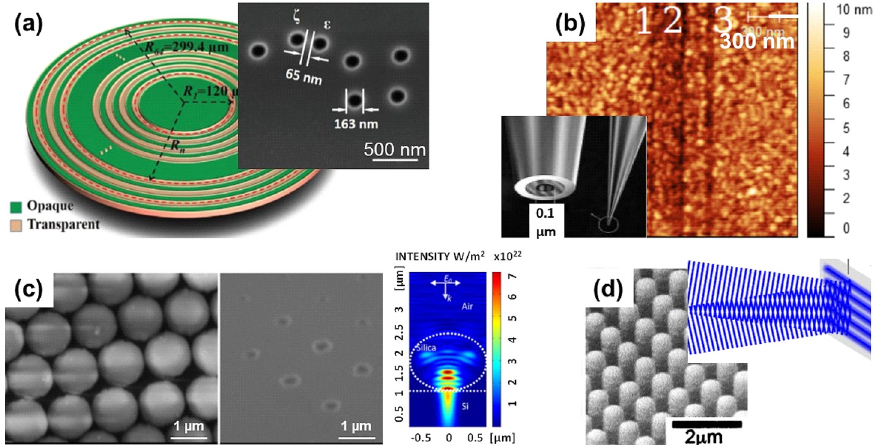
Figure 4: (a) Type of super-lens design for imaging beyond diffraction limit. Reprinted with permission from a study by Qin et al. [52] ©Wiley. Example of probe-assisted fi eld enhancement for nanoscribing. Reprinted with permission from a study by Falcón Casas and Kautek